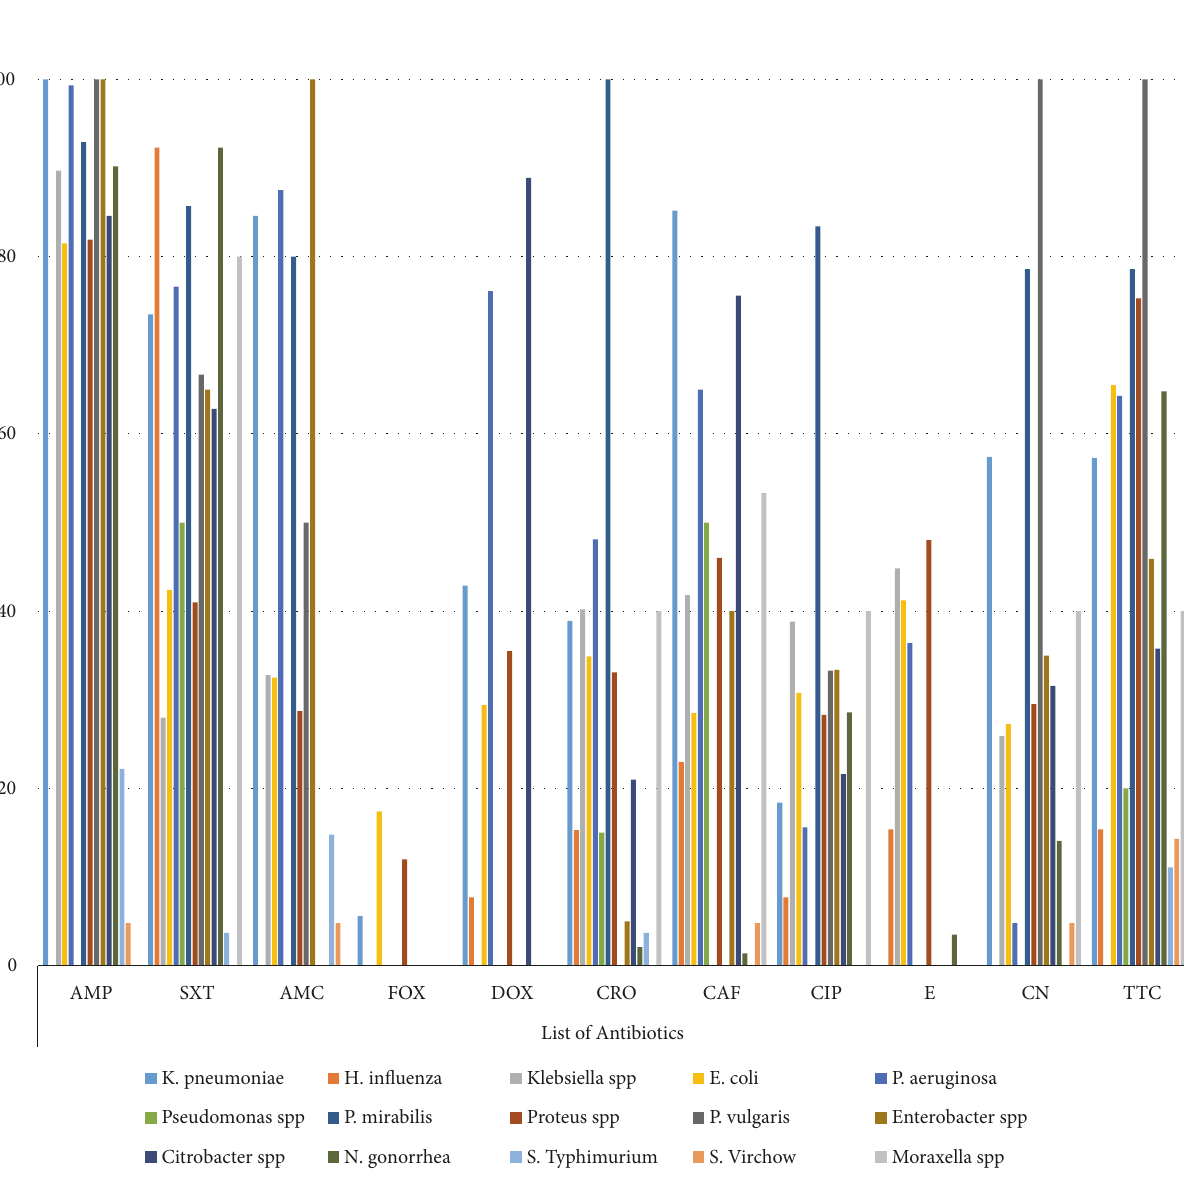
Figure 3: Average resistance pattern of gram-negative bacteria for different antibiotics .